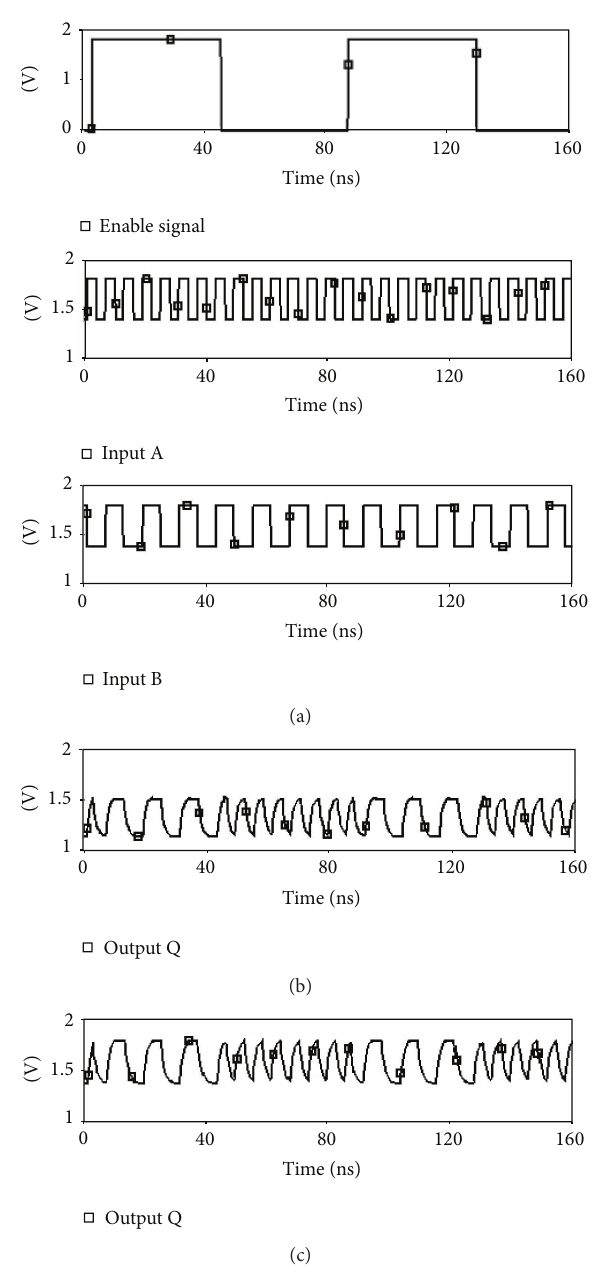
Figure 3: Timing waveform for bus implementation; (a) input signals: Enable, A, and B; (b) output of sleep transistor based bus; (c) output of switch transistor based bus.